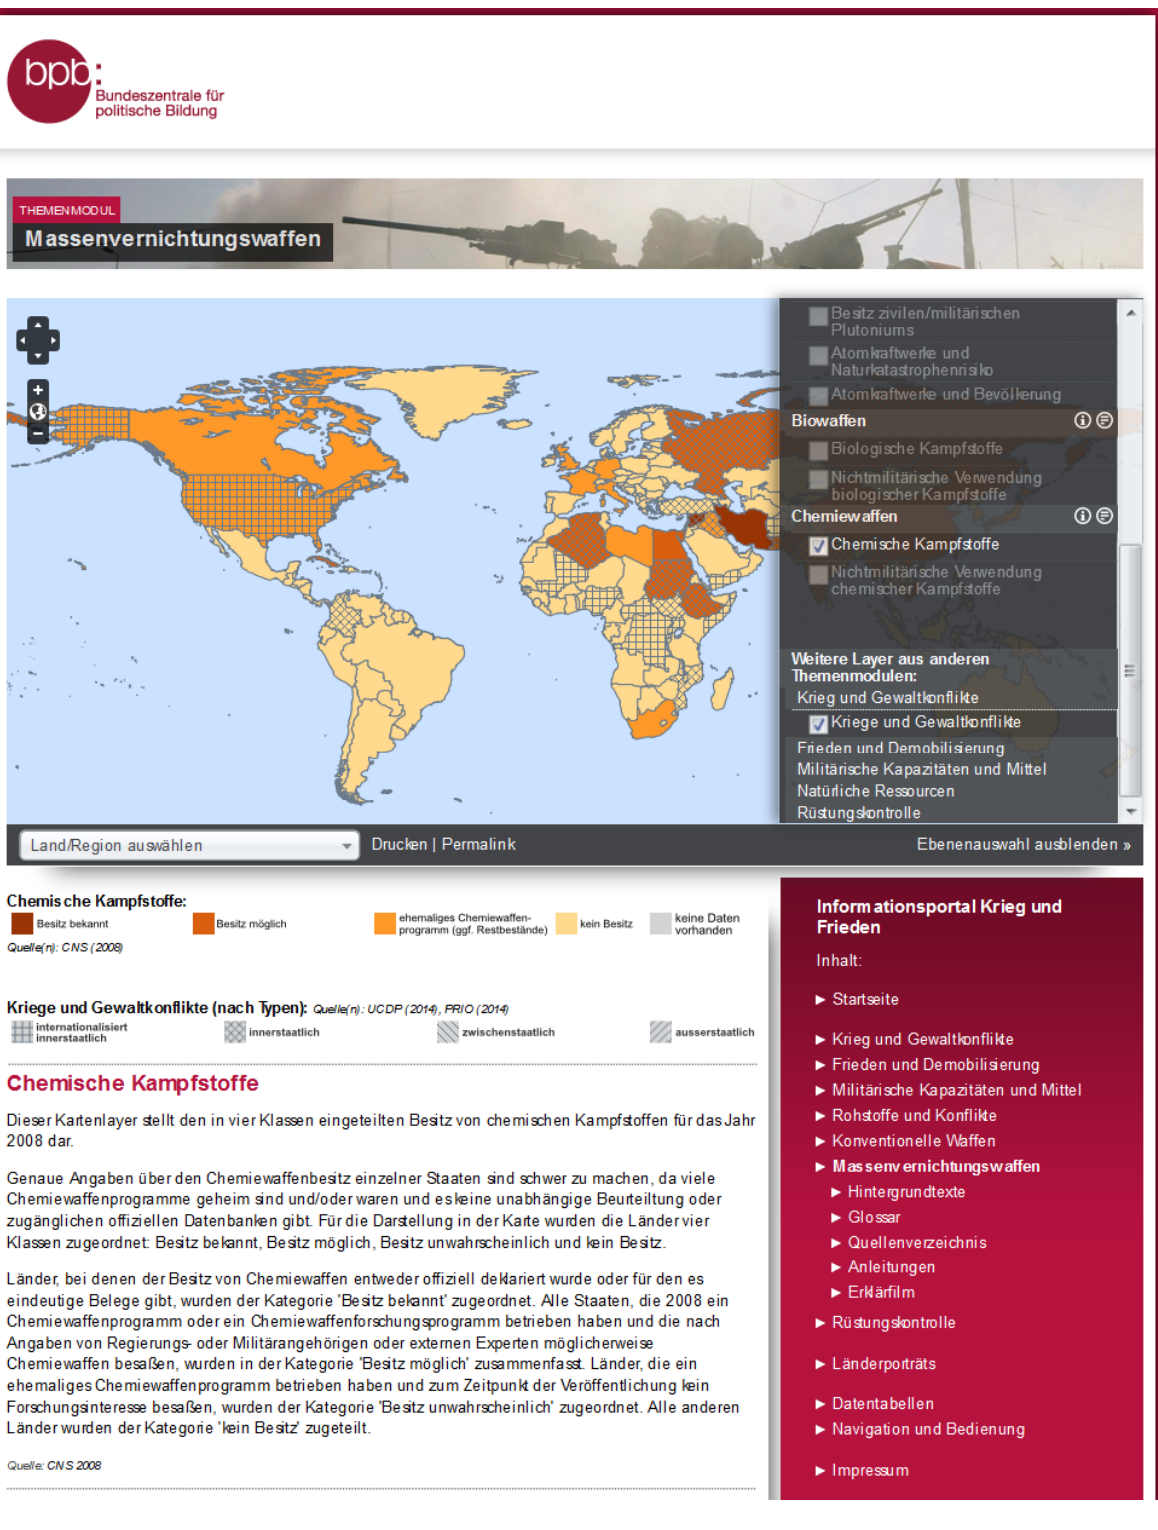
Figure 6. Screenshot—Example chemical warfare